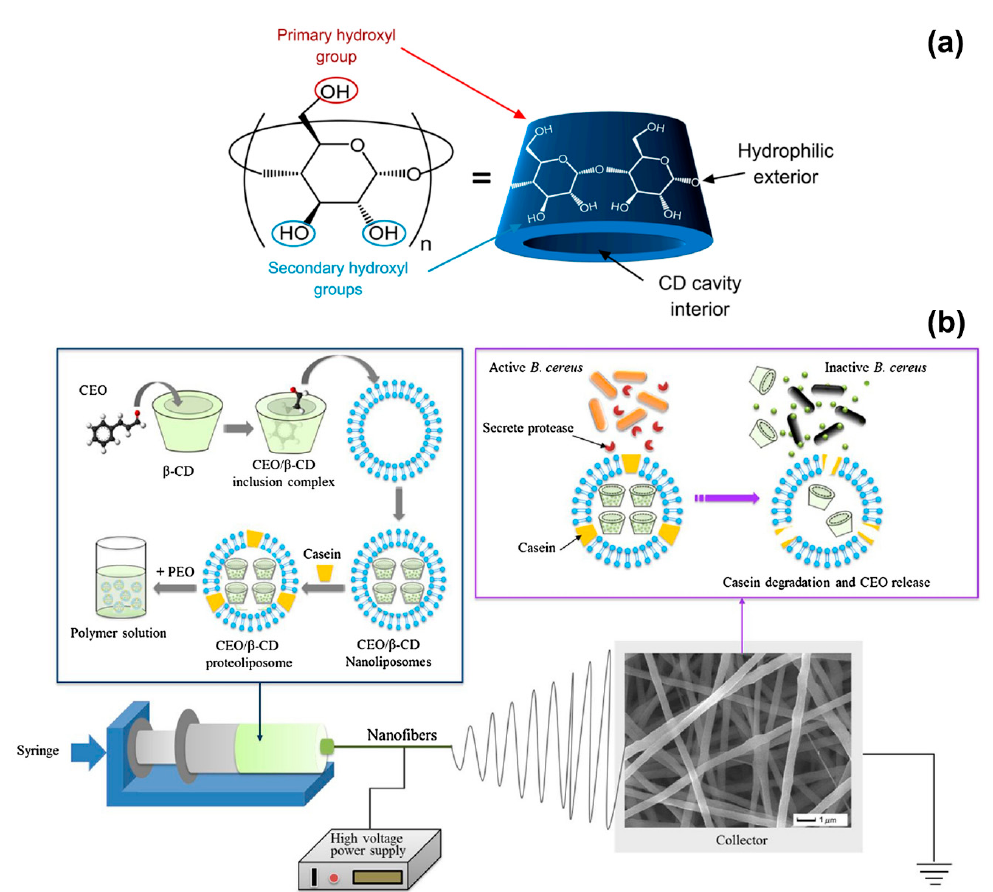
Figure 2. ( a ) Schematic representation of the structure of a cyclodextrin molecule, with indication